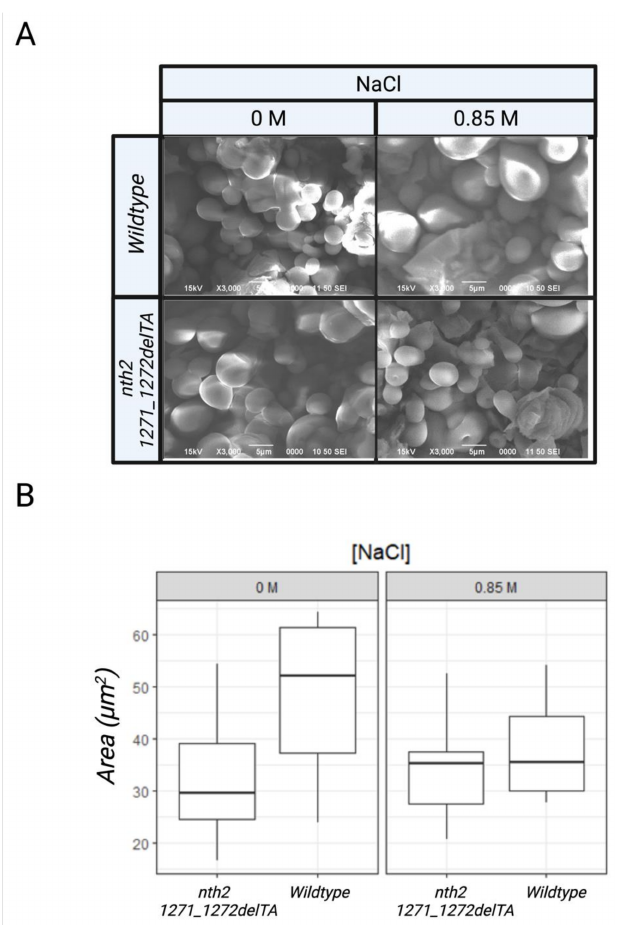
Figure 3. Analysis of the sizes of the wild-type and nth2 1271_1272delTA yeasts. ( A ). Scanning electron microscopy views of the wild-type CEN.PK2-1C strain and mutated strain nth2 1271_1272delTA grown in 0 and 0.85 M NaCl; ( B ). Box plots representing the sizes of the wild-type and nth2 1271_1272delTA strains of yeast under nonstress and stress (NaCl) conditions. No significant difference was observed ( p <